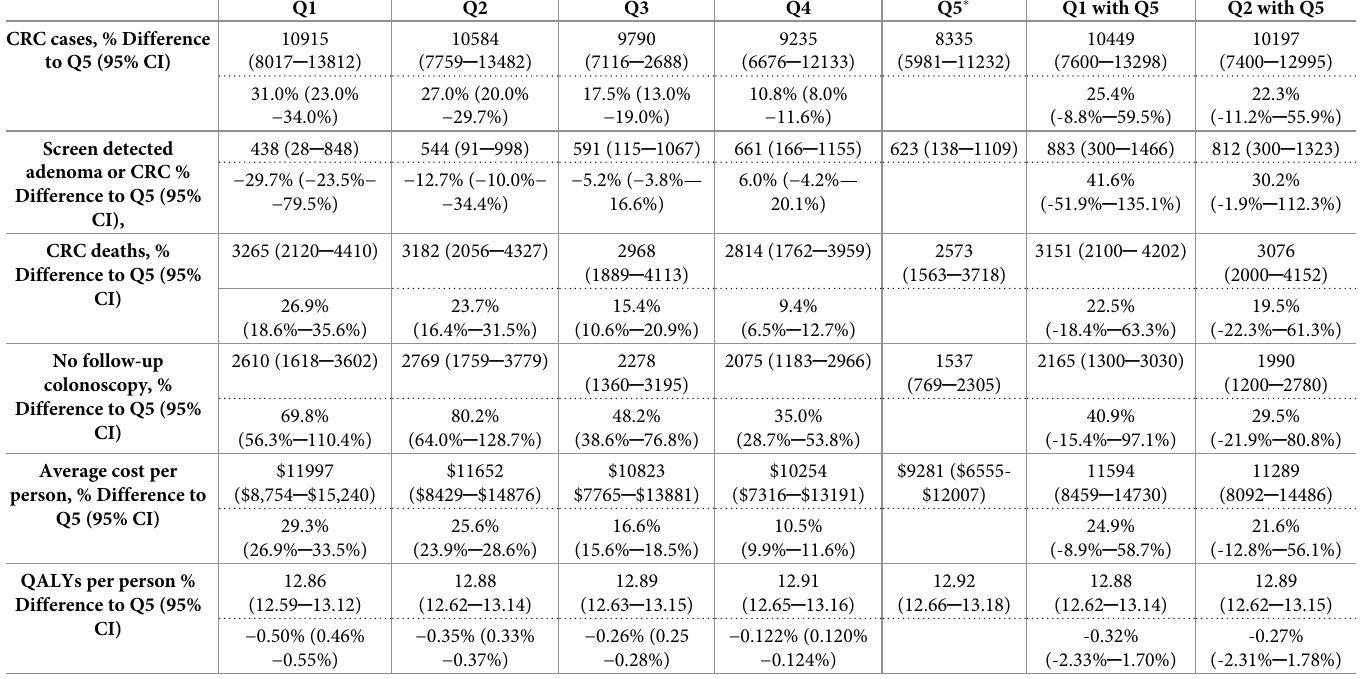
Table 2. Modelled cohort analysis of the health outcomes over the lifetime and substituting screening participation and follow up colonoscopy rates for Q1 and Q2 with Q5